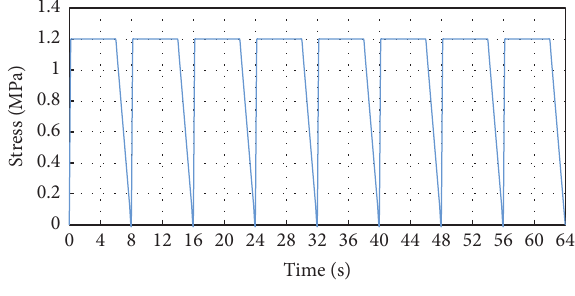
Figure 8: Applied stress-time diagram.